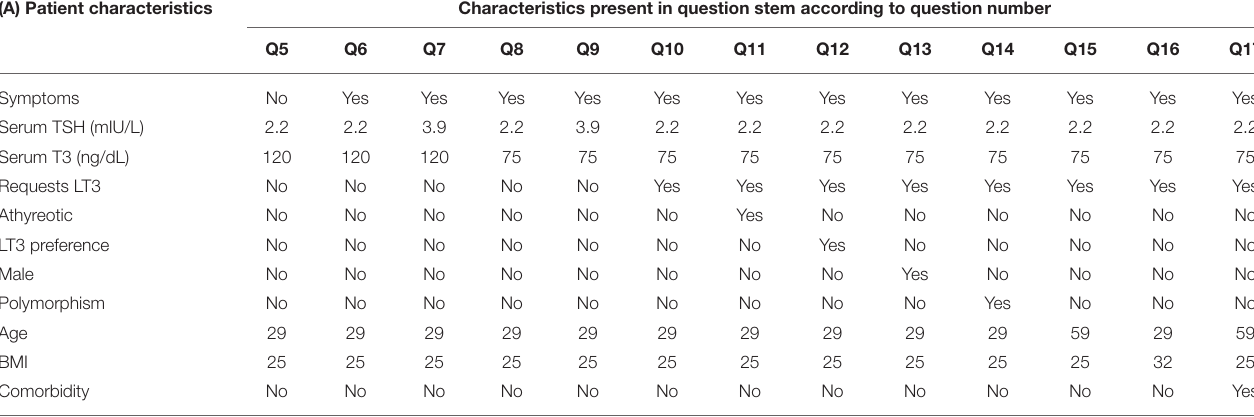
TABLE 1 | Patient characteristics in questions 5–17 * . (A) Patient characteristics